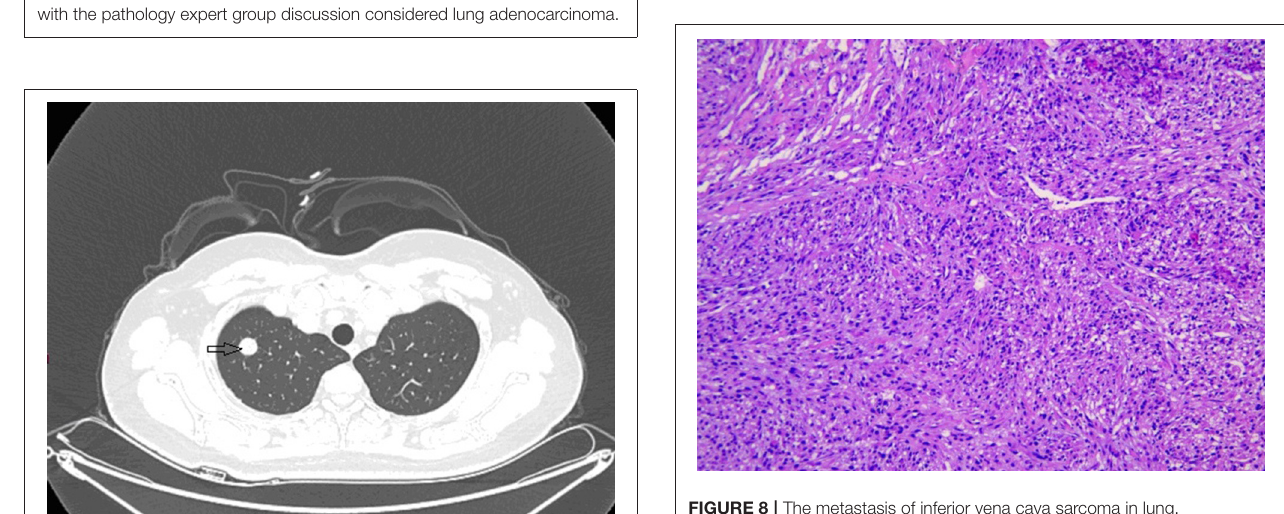
FIGURE 8 | The metastasis of inferior vena cava sarcoma in